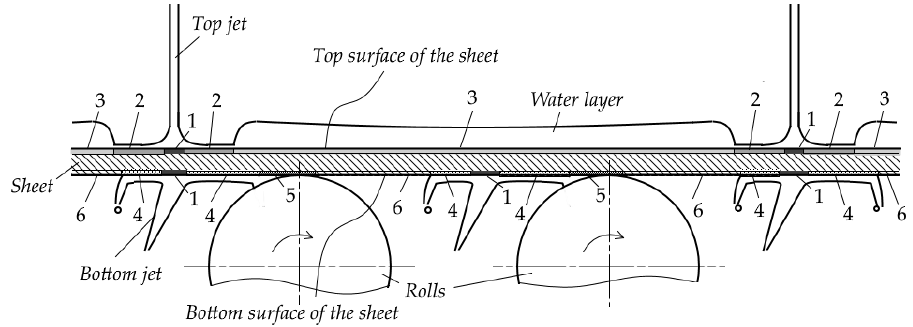
Figure 1. Schematic explaining the types of cooling zones considered in the model (indicated by numbers): 1 — jet impingement; 2 — supercritical flow on the top surface; 3 — subcritical flow on the top surface; 4 — parallel flow on the bottom surface; 5 — contact with a roll; 6 — air cooling.